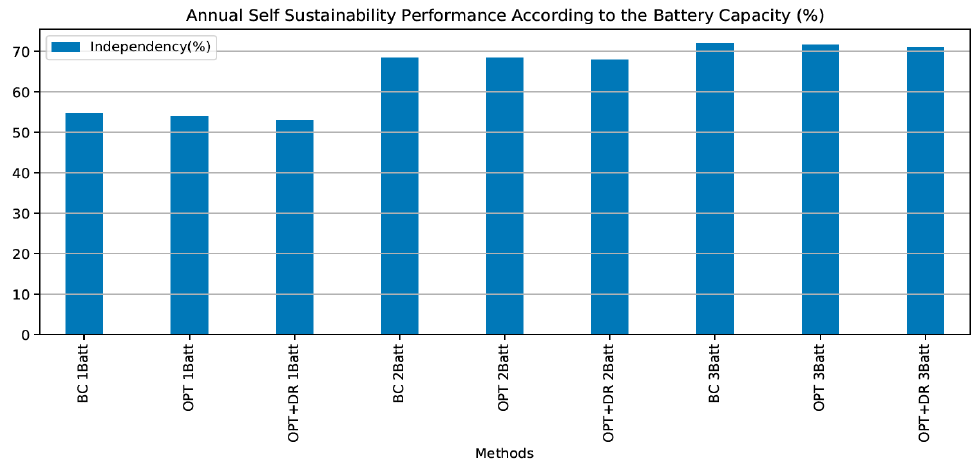
Figure 16. Annual self-sufficiency performance among different cases.